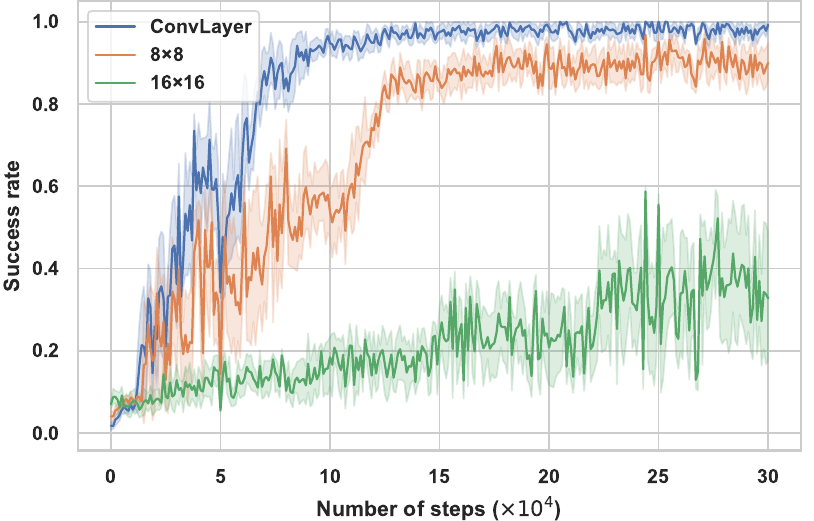
Figure 4. Performance of patching method ablation. Training performances (success rate) of Con- vLayer, 8 × 8 and 16 × 16 patching methods in Push task. Mean and std. deviation of 25 seeds.